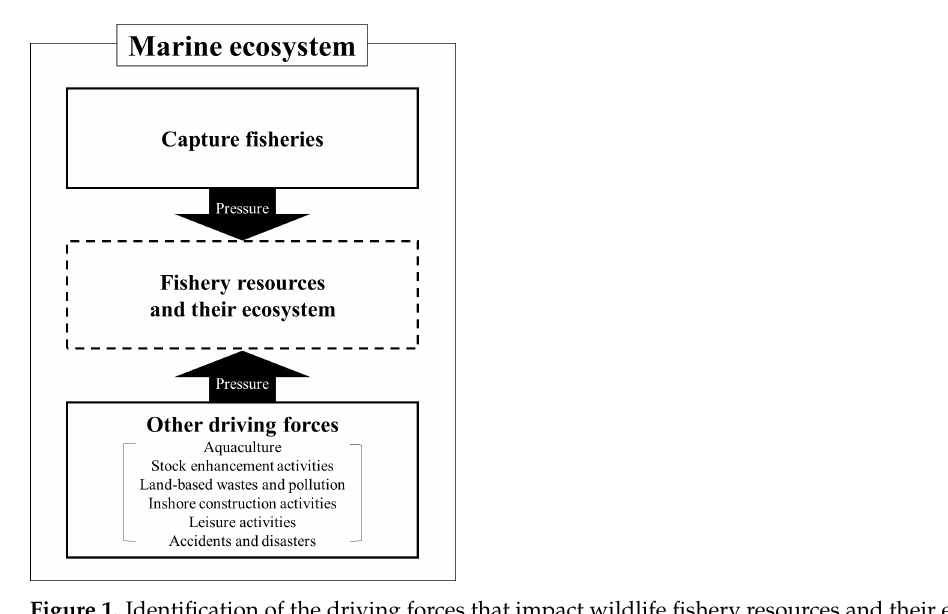
Figure 1. Identification of the driving forces that impact wildlife fishery resources and their ecosys-